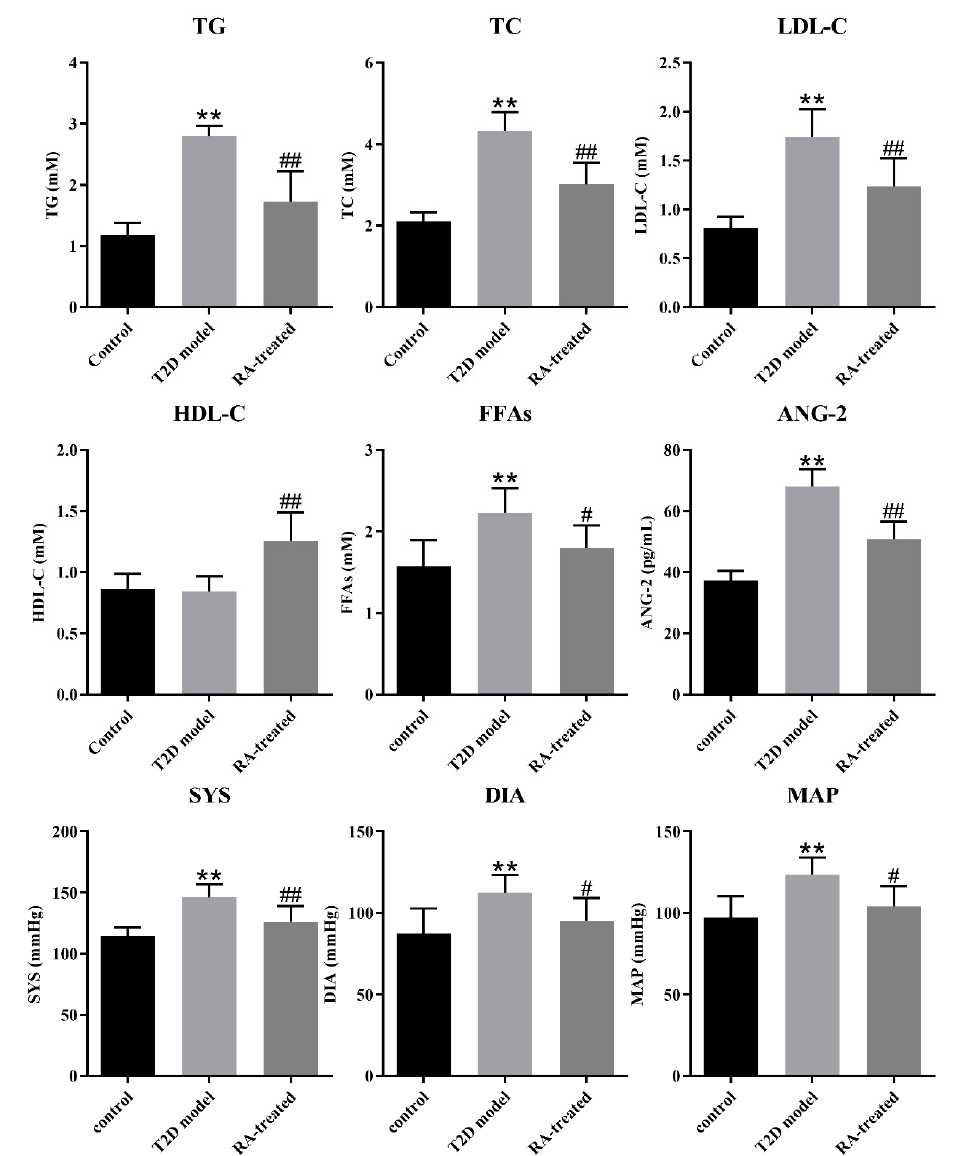
Figure 2. Effects of RA on lipid metabolism (total glyceride (TG), total cholesterol (TC), low-density lipoprotein cholesterol (LDL-C), high-density lipoprotein cholesterol (HDL-C) and free fatty acids (FFAs)) and blood pressure (angiotensin-2 (ANG-2), systolic blood pressure (SYS), diastolic blood pressure (DIA) and mean arterial pressure (MAP)). Data were presented as the mean ± SD ( n = 8 per group). ** p < 0.01 vs. control group; # p < 0.05 vs. T2D model group; ## p < 0.01 vs. T2D model group by Tukey’s multiple comparison test.